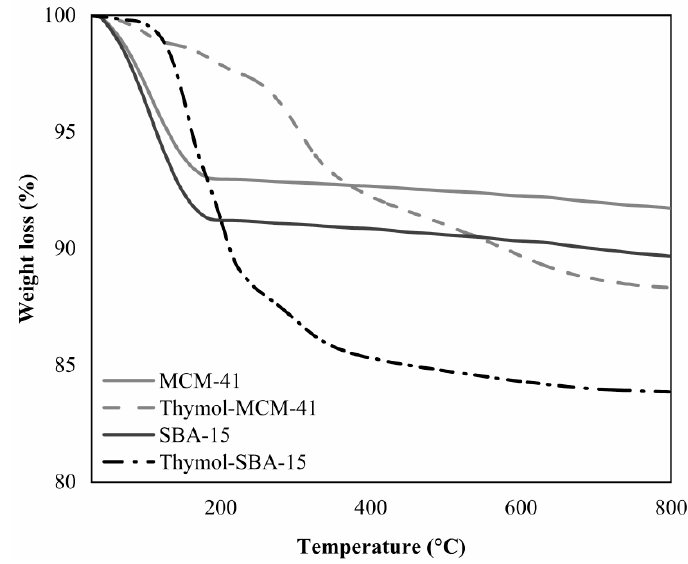
Figure 4. TGA curve of MCM-41, SBA-15, Thy-MCM-41, and Thy-SBA-15.